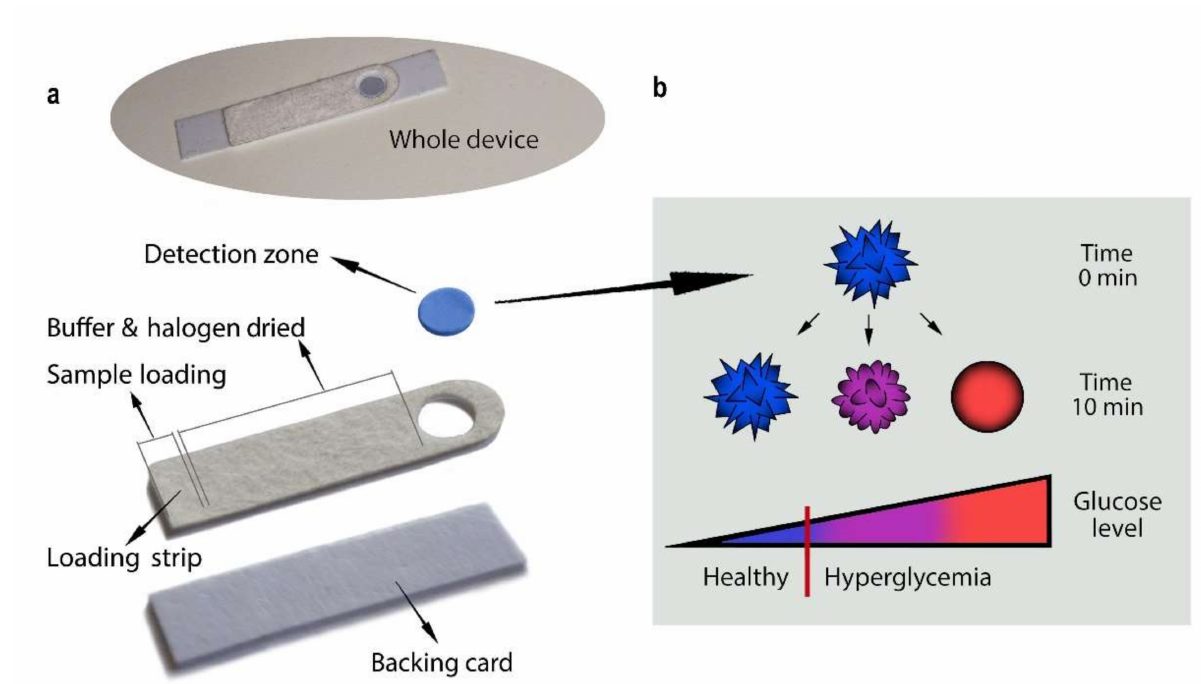
Figure 1. Device structural and functional scheme. ( a ) Representative photographs of the whole device and its comprising parts. The detection zone is constituted by a polyamide membrane func- tionalized with MGNPs and GOx. The loading strip is a Fusion5 ® membrane, where the phosphate buffer and sodium iodide have been dried. The reaction zone and loading strip are held together on an adhesive backing card. ( b ) Sensing scheme and colorimetric results. This device is designed to recognize a healthy level of glucose and two increasing levels of hyperglycemia. Depending on the glucose concentration in the salivary fluid, MGNPs retain their surface structure (blue color), are partially (purple) or are totally (red) and reshaped into spherical GNPs. The colorimetric results can be read 10 min after the sample